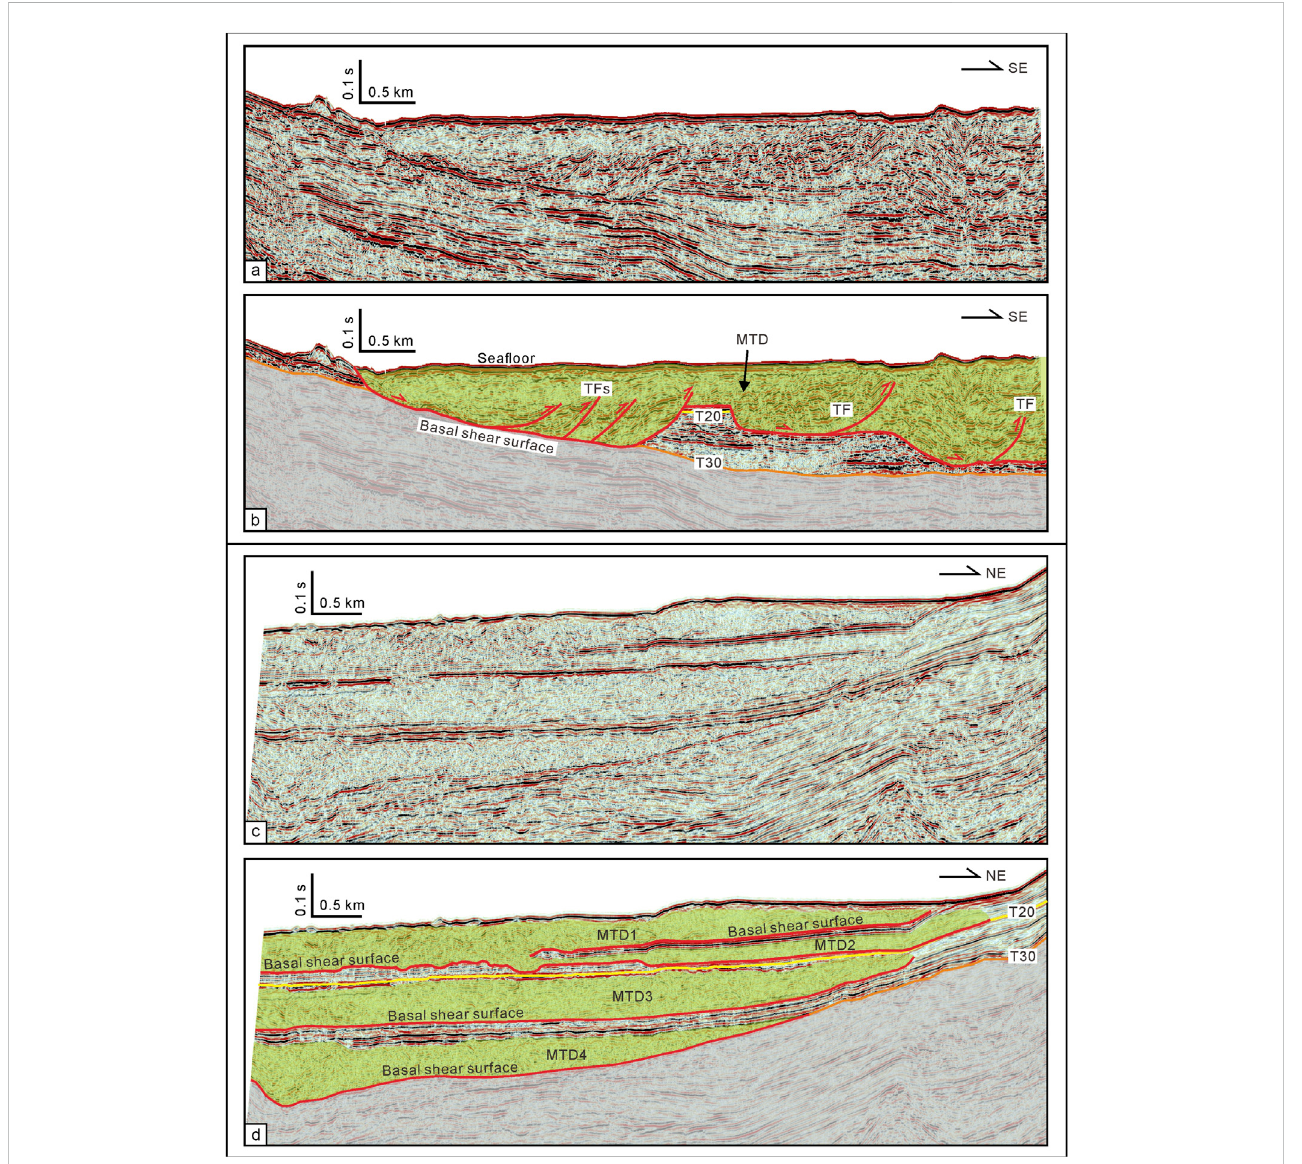
FIGURE 6 Detailed imagesof mass transport deposits (MTDs) along the seismic pro fi les Line 2 and Line 3 with not interpreted (A, C) and interpreted (B, D) versions. SeeFigures4,5forlocations.Redlinesmarkthebasalshearsurfacesandthrustfaults(TF).Translucentgrassgreenareasmarkthecon fi gurationofMTDs.T20 and T30: seismic re fl ectors. The depth was two-way travel